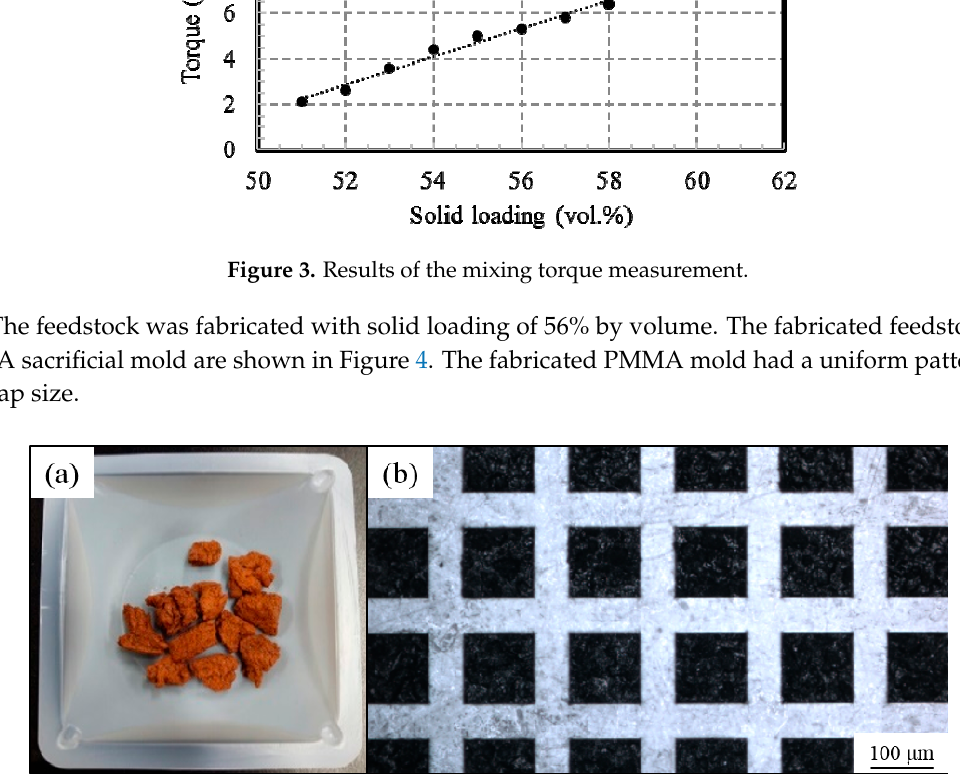
Figure 5. Rectangular mold cavity (inside the red rectangle).